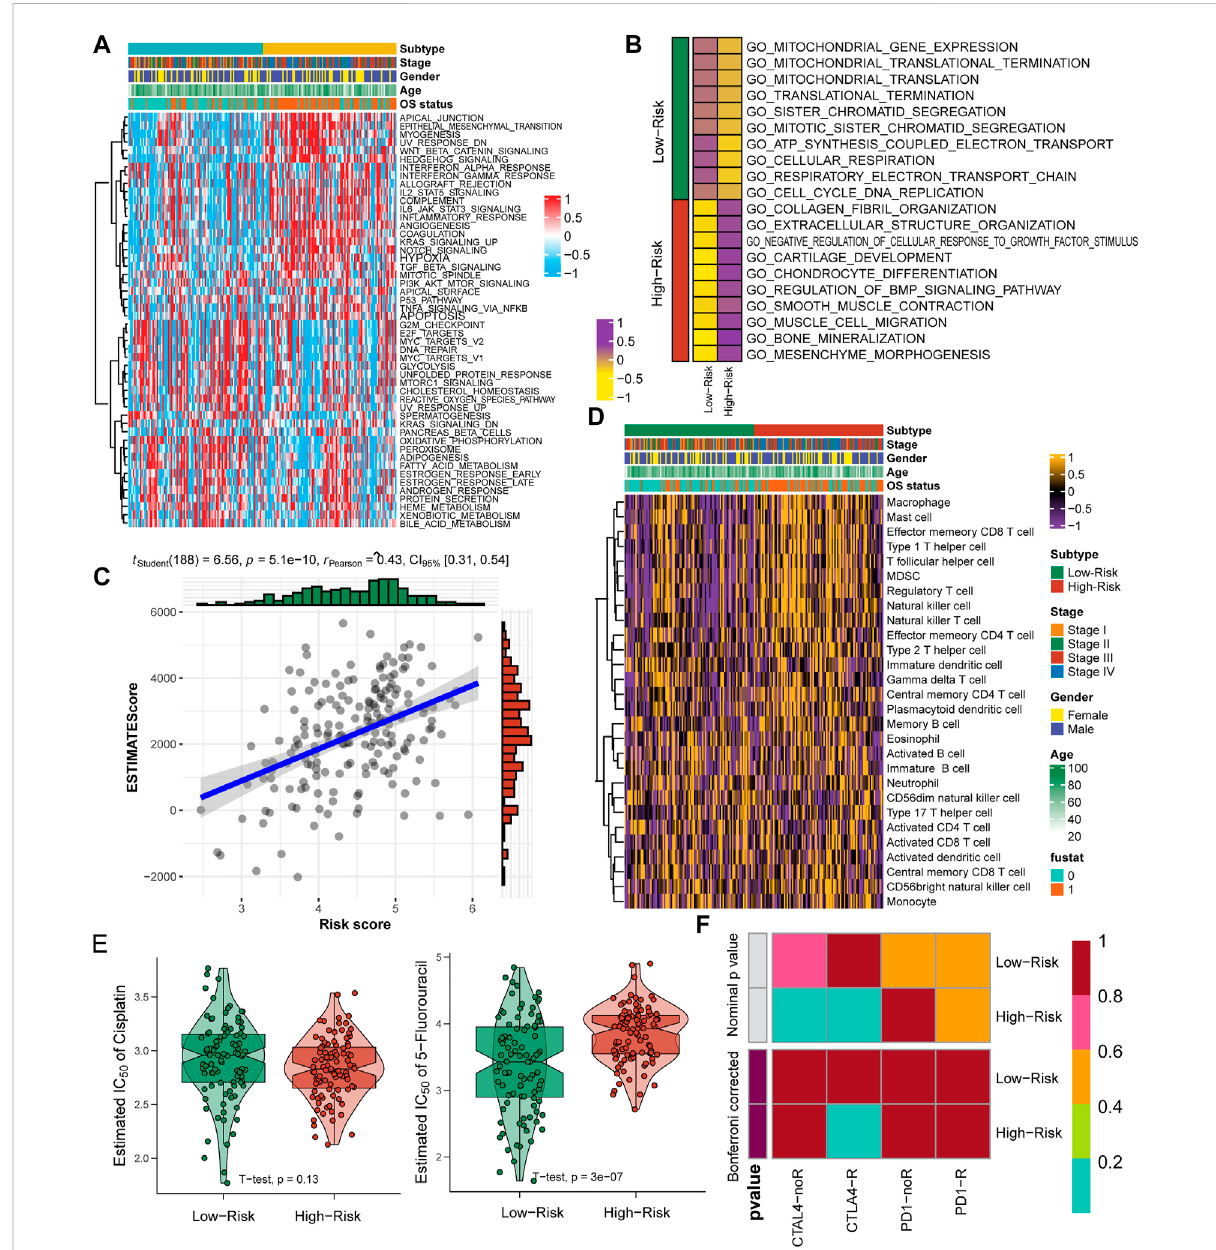
FIGURE 7 Speci fi c molecular features and suitable treatment strategies for low-risk and high-risk GC patients. (A) , Heatmap showing the enrichment of 50 HALLMARK tumor pathways; (B) , Enrichment of GO terms in two risk groups; (C) , Correlation between nine-consensus-prognostic-gene signature generated risk score and the tumor in fi ltration ESTIMATE score; (D) , Heatmap showing the in fi ltration of 28 immunocyte gene sets; (E) , Estimated IC50 of cisplatin and 5- fl uorouracil treatment in high-risk and low-risk subgroups; (F) , Submap analysis showing the potential response to anti-CTAL4 and anti-PD-1 therapy in high-risk and low-risk